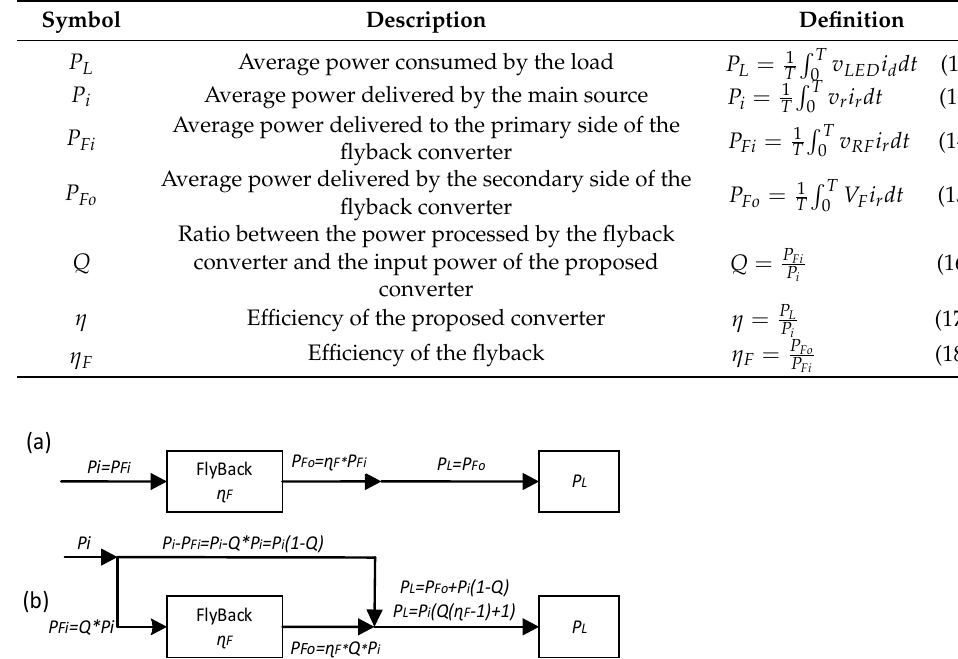
Figure 9. Power flow diagrams, ( a ) conventional flyback and ( b ) proposed rearranged flyback. P i is the input power to the converter.